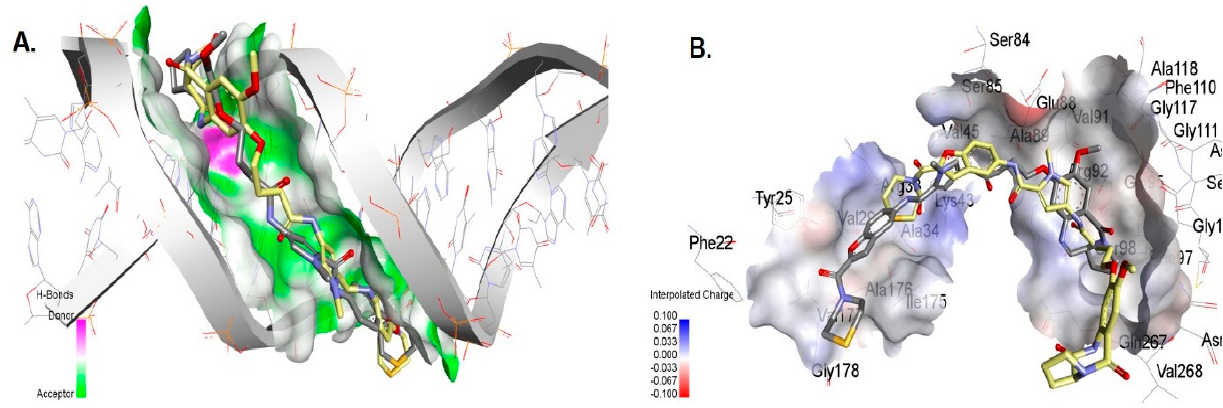
Figure 3. ( A ) DNA binding of compounds 7 (grey) and 7a (yellow) within the DNA minor groove of Sequence 1; ( B ) Interaction of 7 (grey) and 7a (yellow) within the binding pocket of DNA gyrase A from Staphylococcus aureus , showing differences in site occupancy.